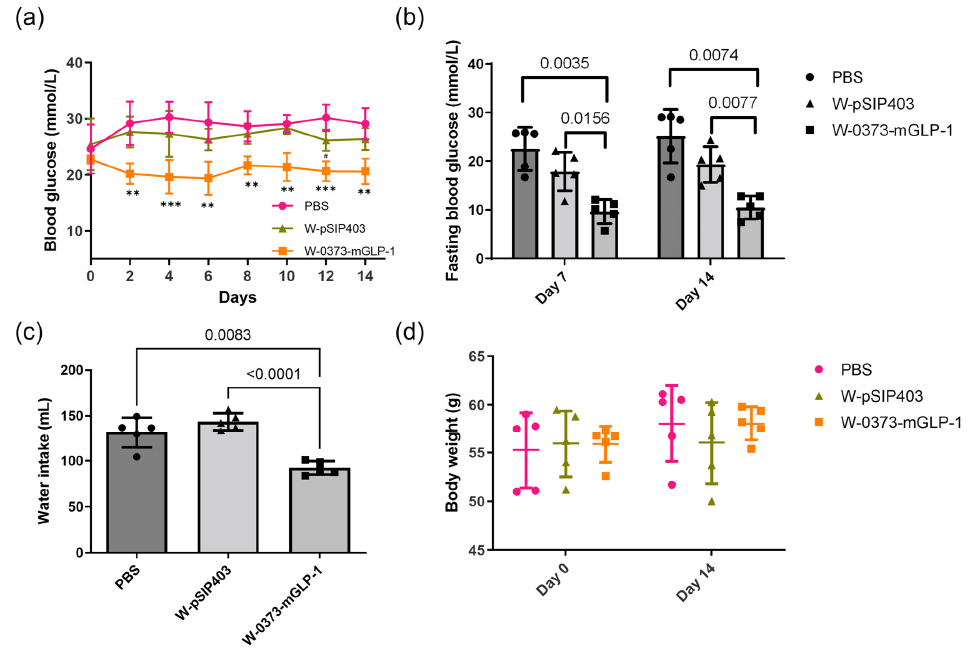
Figure 5. Effects of 14-day W-0373-mGLP-1 administration on ( a ) non-fasting blood glucose during administration, ( b ) 7- and 14-day fasting blood glucose, ( c ) random water intake per cage of different groups during administration in db/db mice, and ( d ) body weight. All data are represented as mean ± SD. ** p < 0.01, *** p < 0.001 compared with PBS group. Following an intraperitoneal glucose injection, the blood glucose concentration and corresponding AUCs were measured until 180 min (Figure 6a,b). The blood glucose of db/db mice receiving W-0373-mGLP-1 treatment was signi fi cantly lower at all time points compared with db/db controls ( p < 0.01). The corresponding area under the glu- cose curve was also signi fi cantly reduced ( p = 0.0018). Although there was no signi fi cant